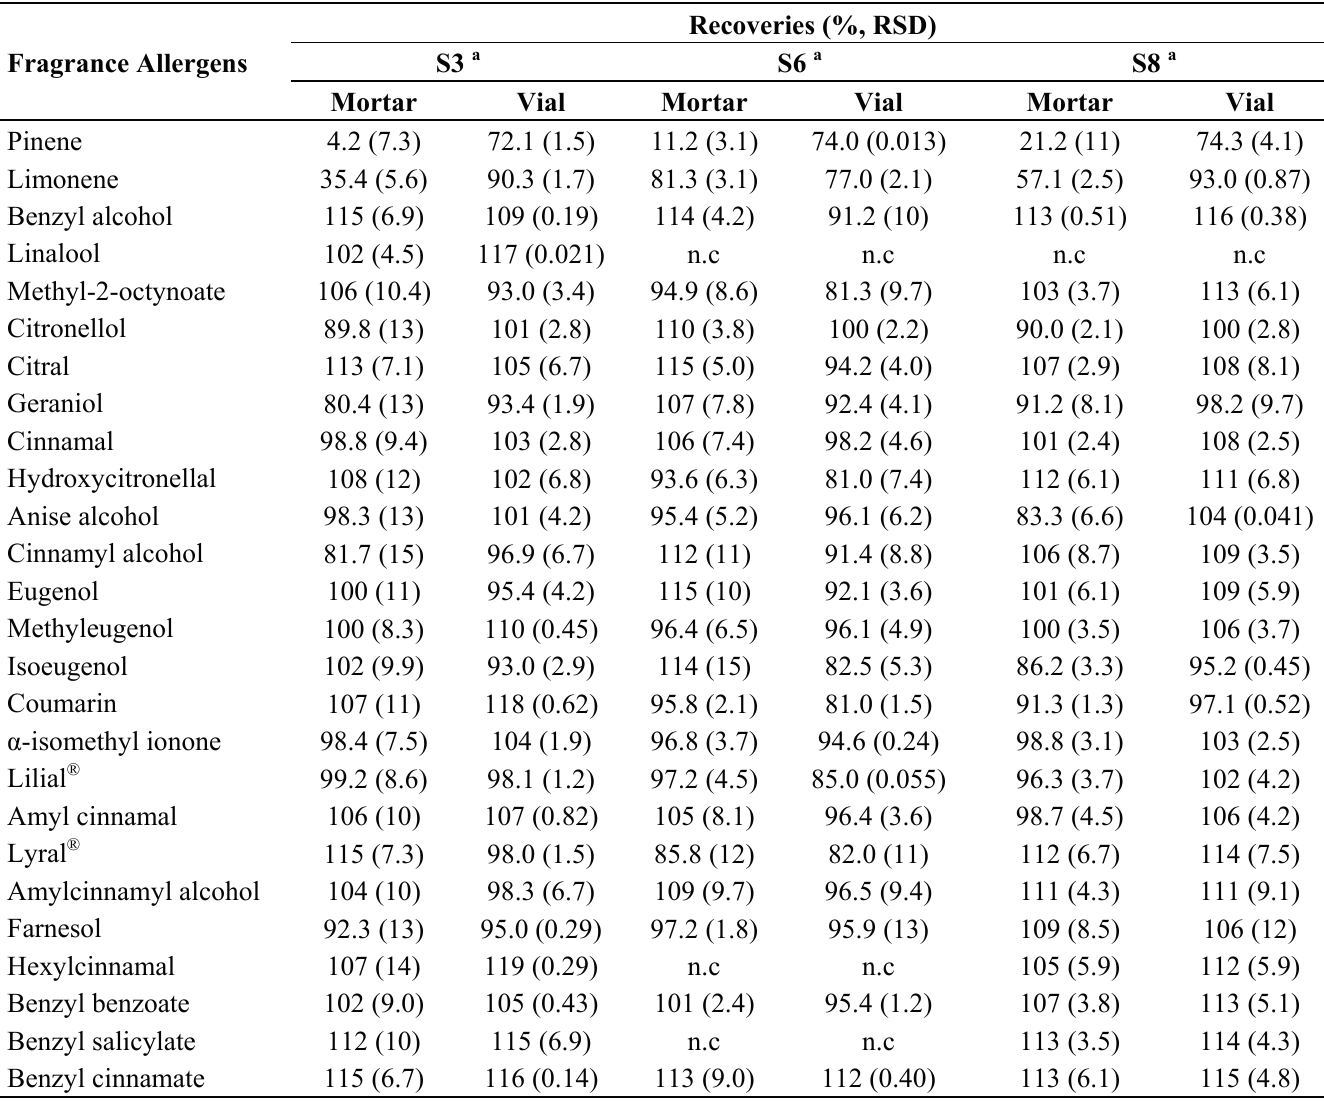
Table 6. Recovery study in different cosmetic matrices. Spike level: 10 µg·g − 1